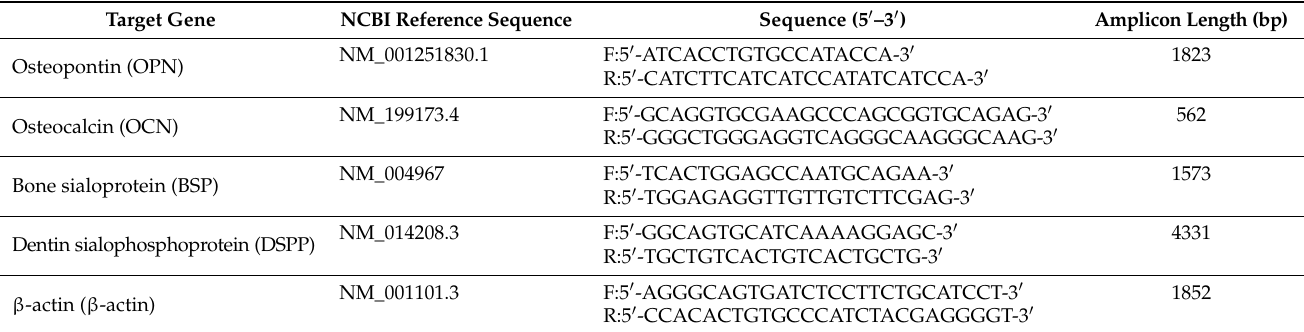
Table 1. Genes and primers used in qRT-PCR